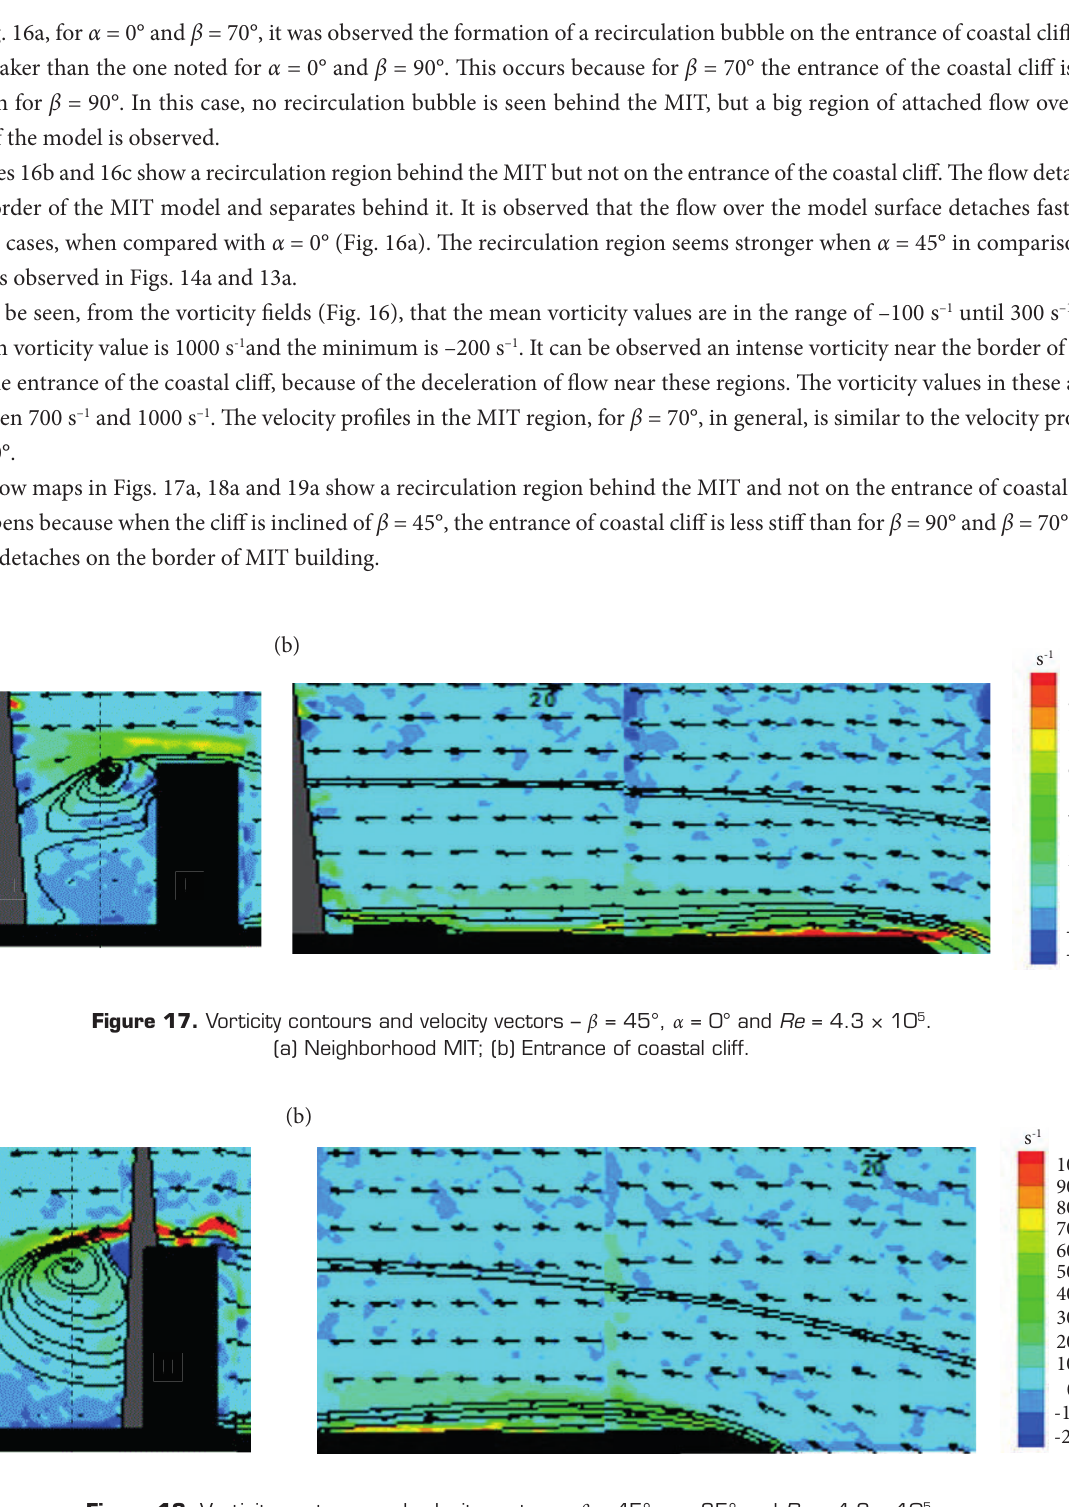
Figure 18. Vorticity contours and velocity vectors – β = 45°, α = 35° and Re = 4.3 × 10 5